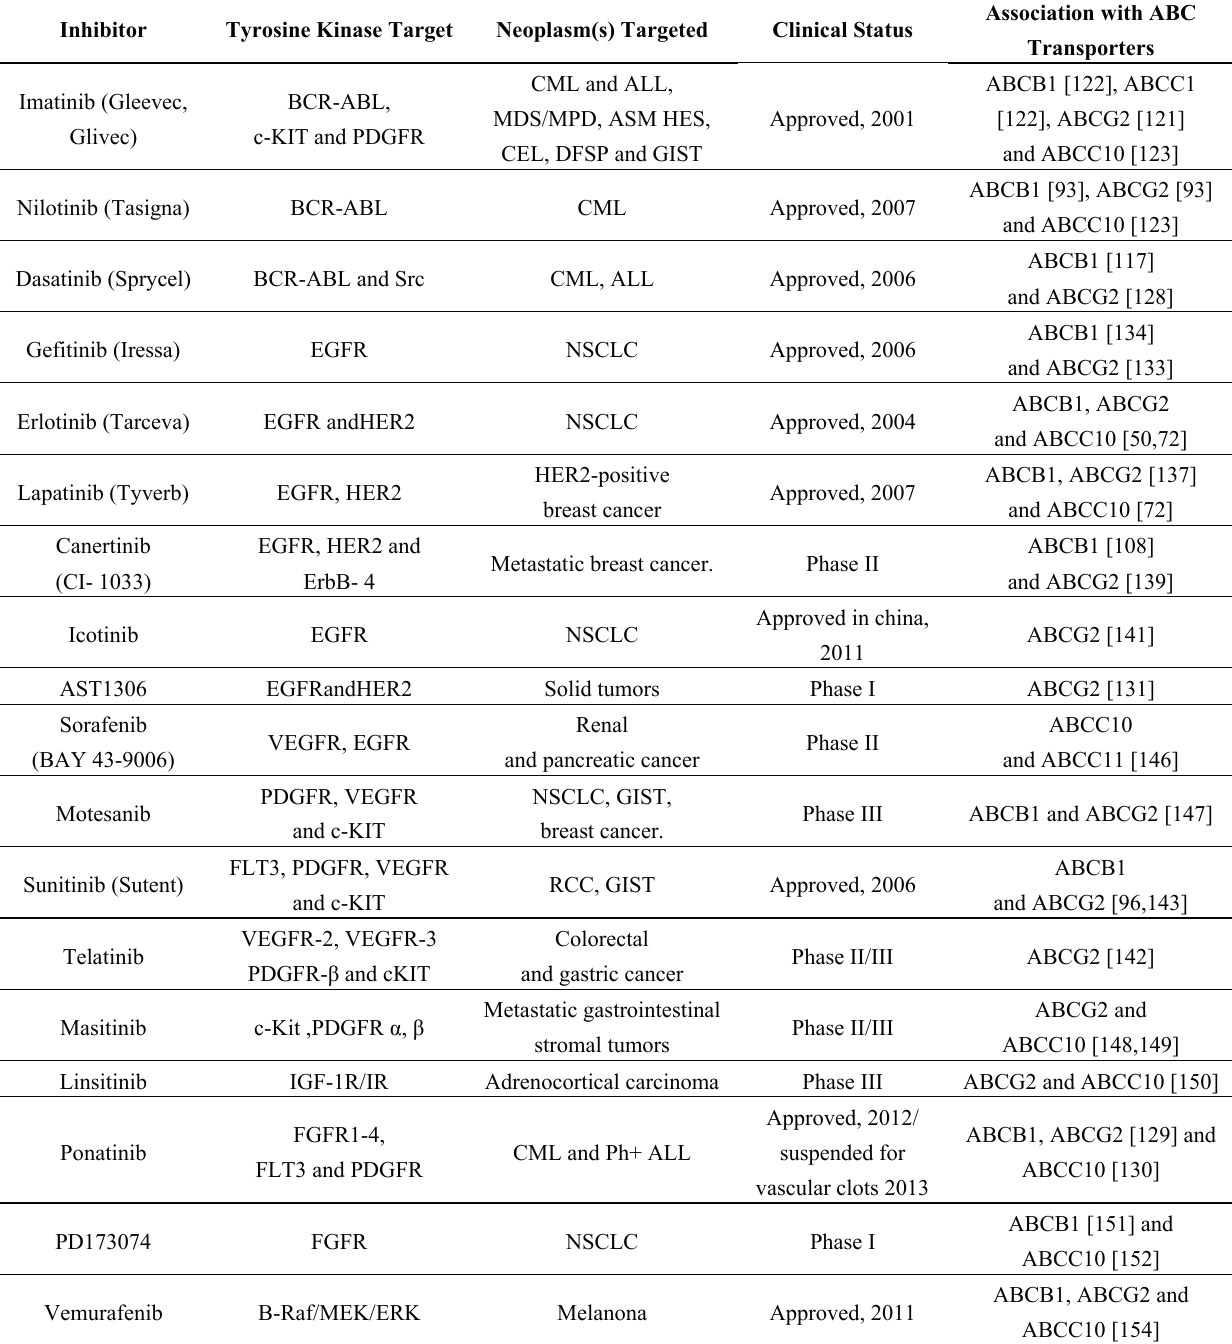
Table 1. Tyrosine Kinase Inhibitors and their association with ABC drug transporters. Inhibitor Tyrosine Kinase